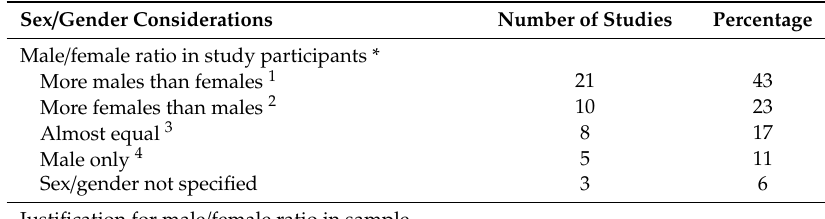
Table 2. Integration of sex / gender in the included articles (n =